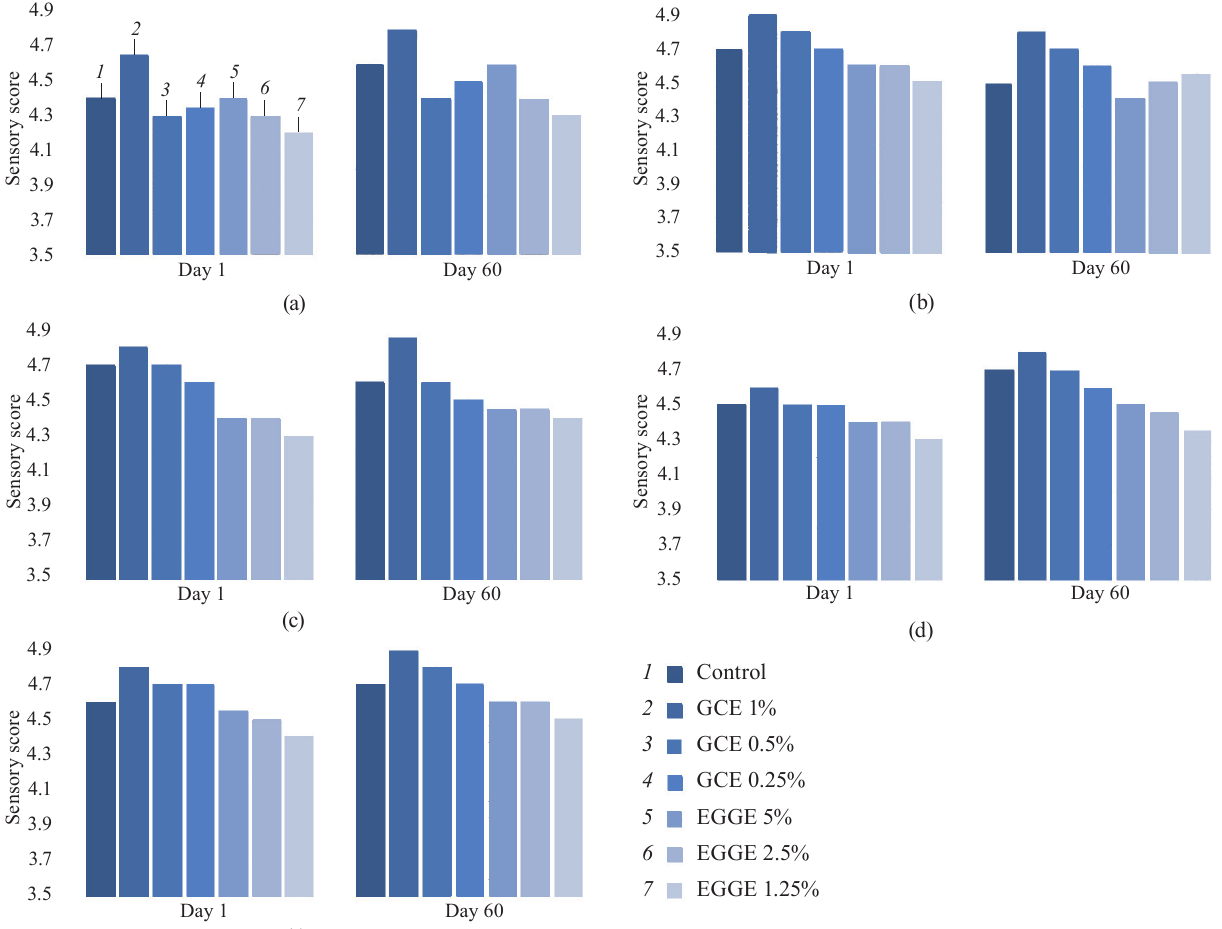
Figure 5 Sensory attributes of kashk samples supplemented with GCE on day 1 and day 60: (a) Color; (b) Odor; (c) Taste; (d) Consistency; (e) Total